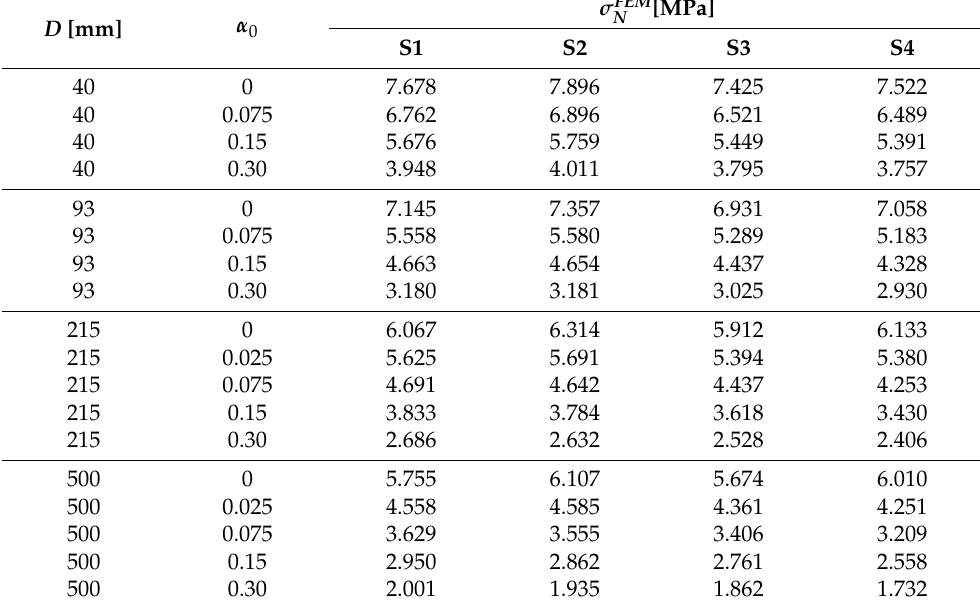
for bilinear softening curves and sets N